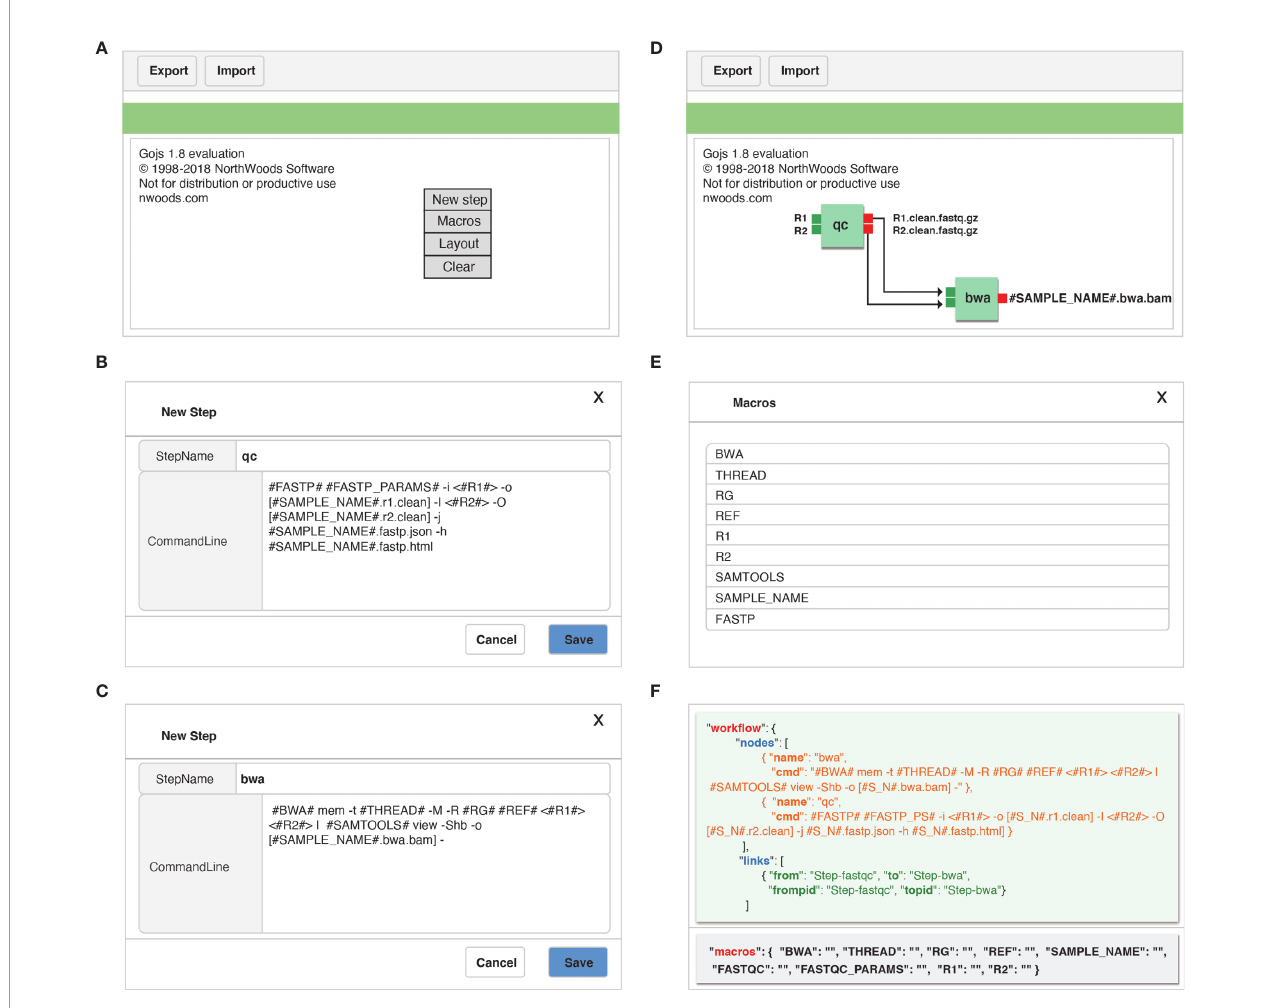
FIGURE 3 | Detailed operations for creating a new step by using GPyFlow-Visual. (A) GPyFlow-Visual web portal. (B) Edited a new step named “ qc ” . (C) Edited a new step named “ bwa ” . (D) Link step “ qc ” to “ bwa ” to make a fl ow. (E) View macros in the fl ow. (F) JSON fi le of the fl